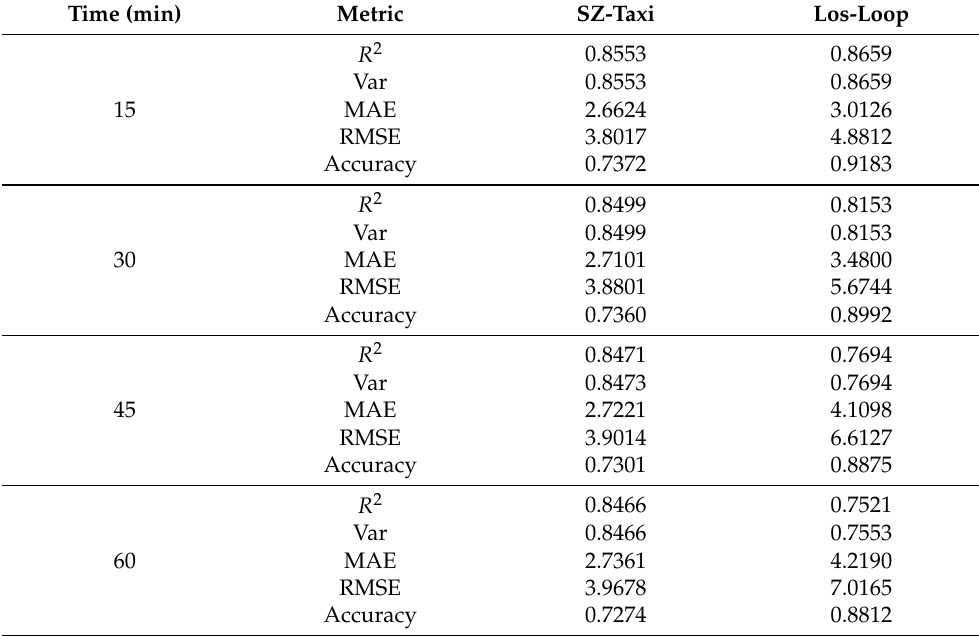
Table 1. MHSA–GCN traffic prediction evaluation on the SZ-taxi and Los-loop